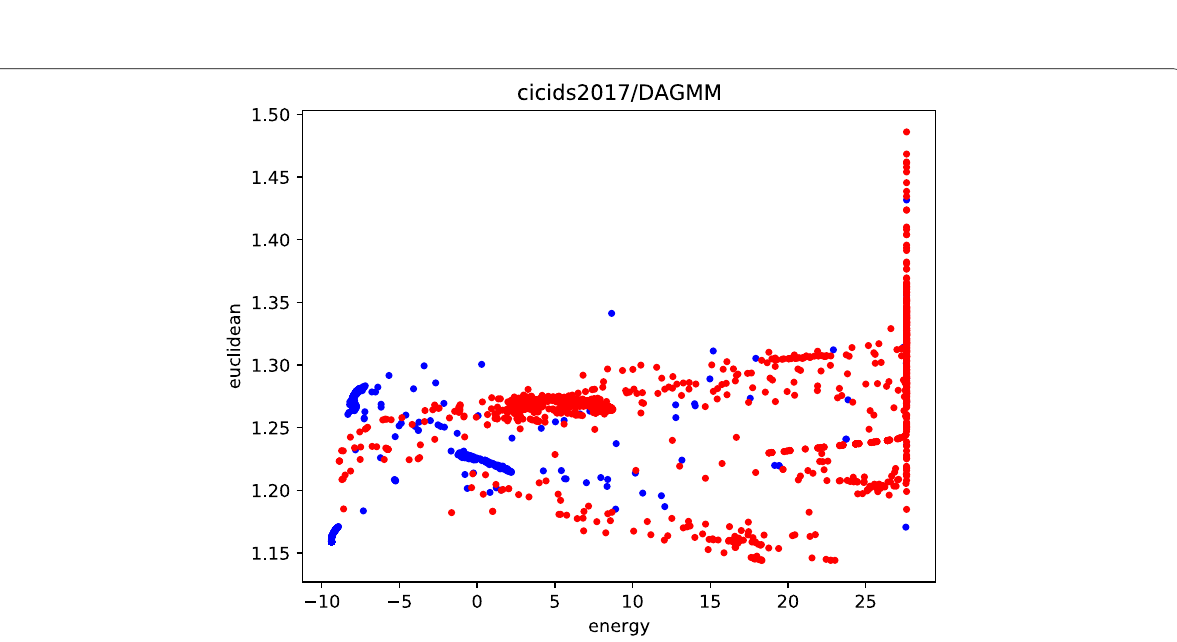
Fig. 14 Low-dimensional information of CIC-IDS-2017 sample after DAGMM